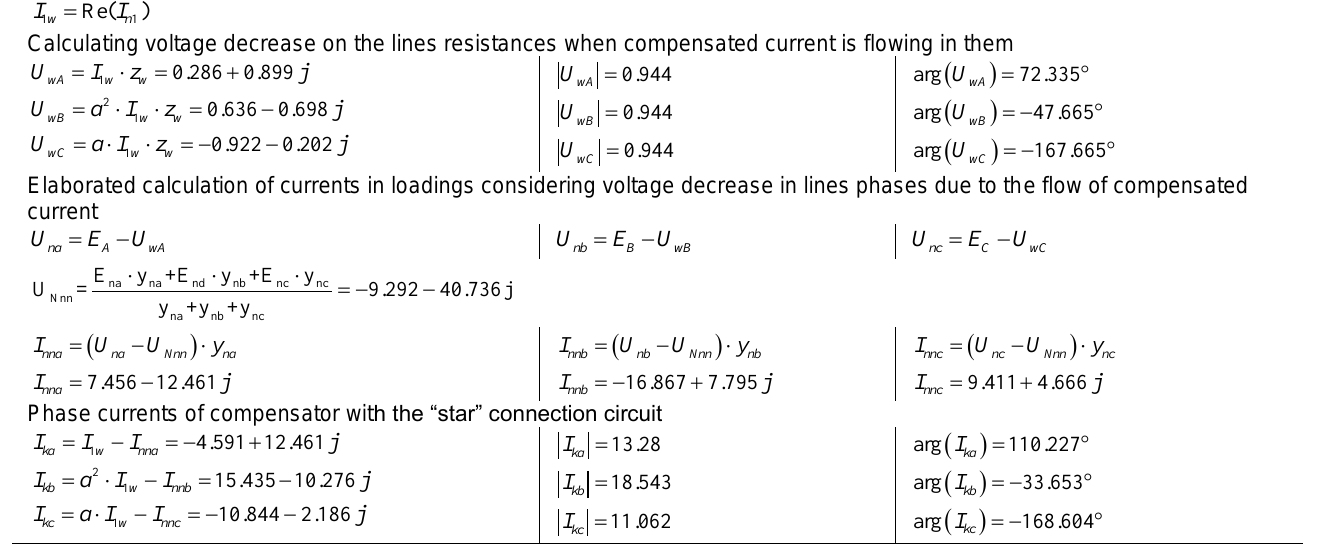
Calculating voltage decrease on the lines resistances when compensated current is flowing in